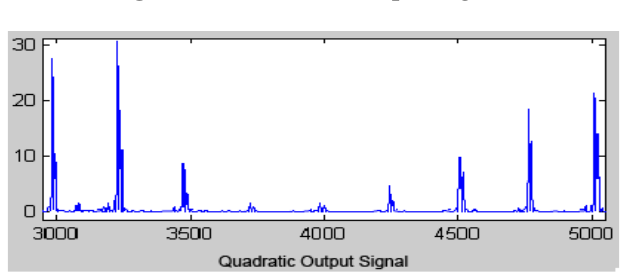
Figure 6. Quadratic output